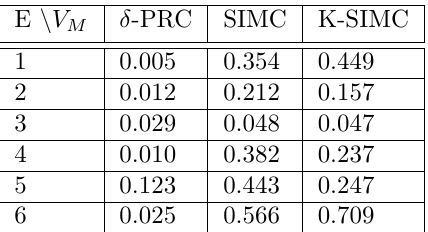
Table 3: Es1-6. The table shows the main performance objective V M (Eq. (8)) measures for the δ - PRC, K-SIMC and SIMC tuned PID con- trollers, i.e. corresponding to the trade-off curves in Figure 4. E \ V M δ -PRC SIMC K-SIMC 0.005